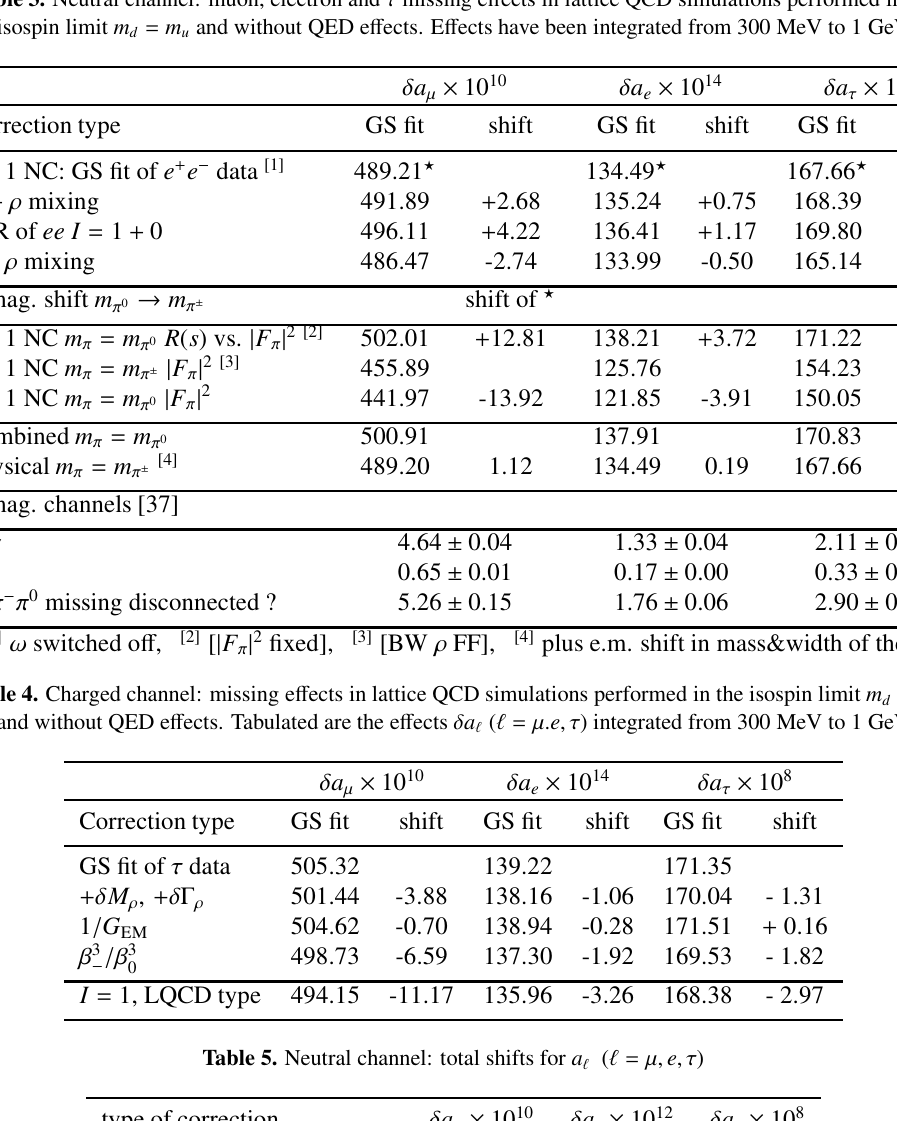
Table 3. Neutral channel: muon, electron and τ missing e ff ects in lattice QCD simulations performed in the